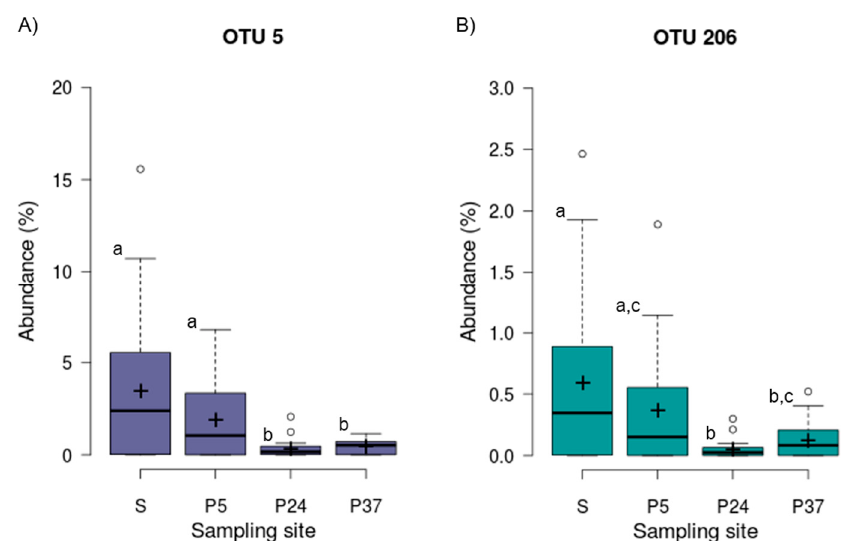
Figure 5. Box and whisker plots showing the abundance variation of OTU5 ( A ) and OTU 206 ( B ) across the sampling sites. The thick lines represent the median; the box upper and lower limits indicate the 25th and the 75th percentiles, respectively; the whiskers indicate the data that lie be- yond the 5th percentile (lower whisker) and the 75th percentile (upper whisker); and the dots rep- resent the outliers. The different letters indicate differences between the mean values of different